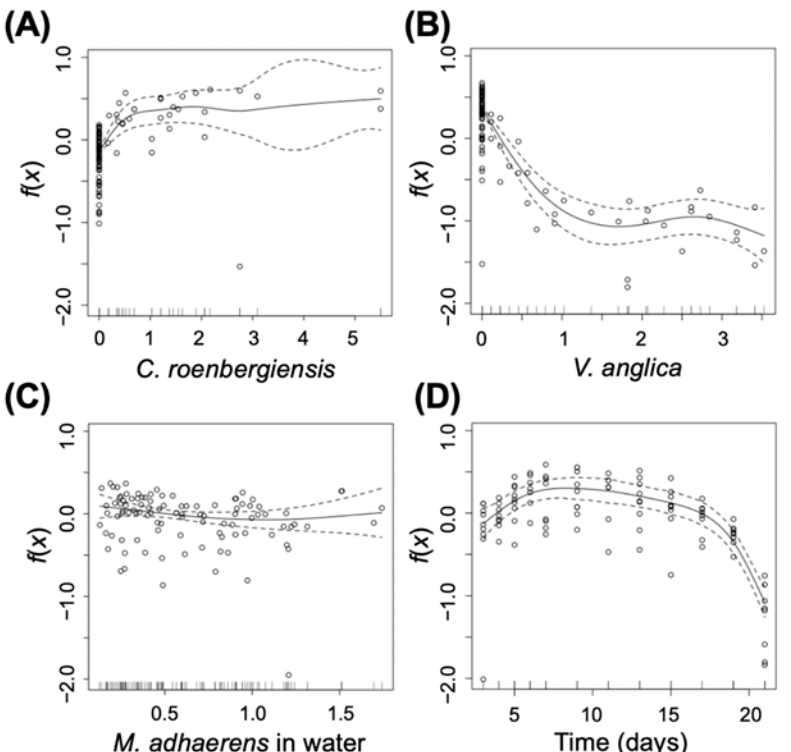
Figure 3. Smoothed fits of covariates modeling the scaled density of surface-attached M. adhaerens for the scaled densities of ( A ) C. roenbergensis , ( B ) V. anglica , ( C ) planktonic M. adhaerens , and ( D ) time. The y -axis represents the spline function. Circles are the data from the experiment. Solid lines represent fitting curves. Dashed lines indicate the 95% confidence intervals.